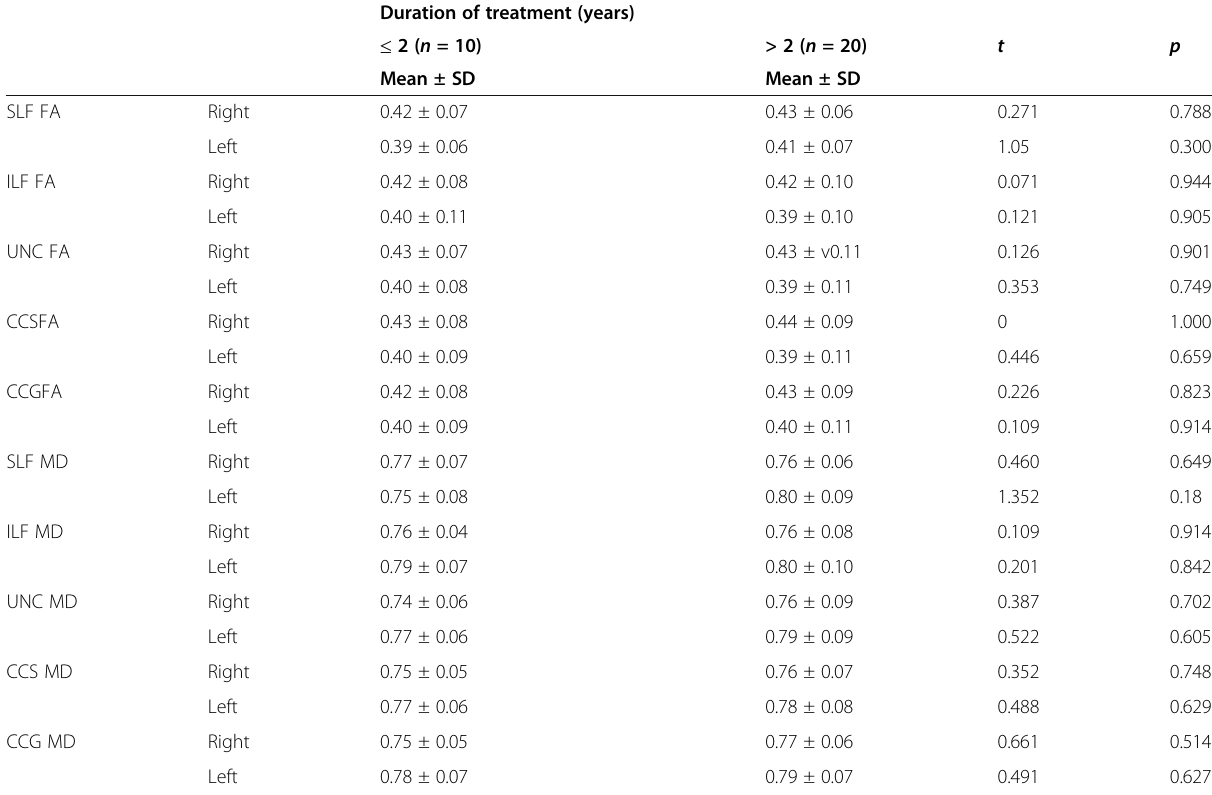
Table 6 Relation between mean values of fractional anisotropy, mean diffusivity and duration of treatment in diabetics ( n = 30) Duration of treatment